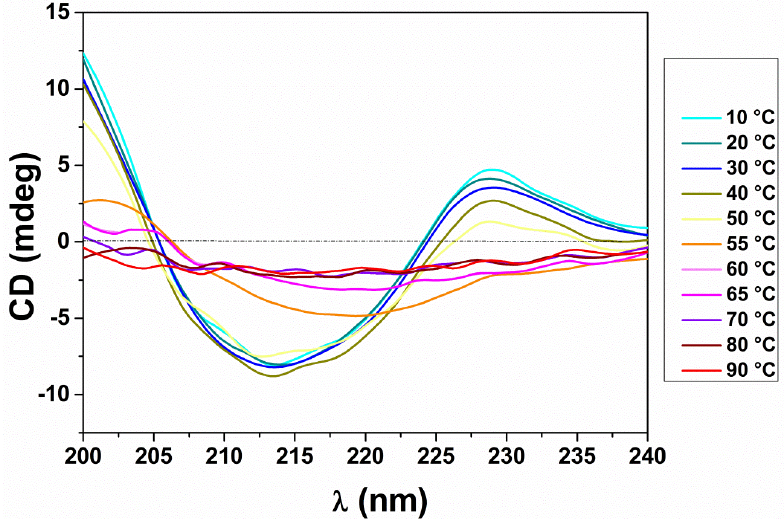
Figure 1. Circular dichroism (CD) spectra for the thermal denaturation assay of GtCel12A. The temperature range is from 10 to 90 °C varied in steps of 10 °C in the beginning of the experiment and steps of 5 °C above 50